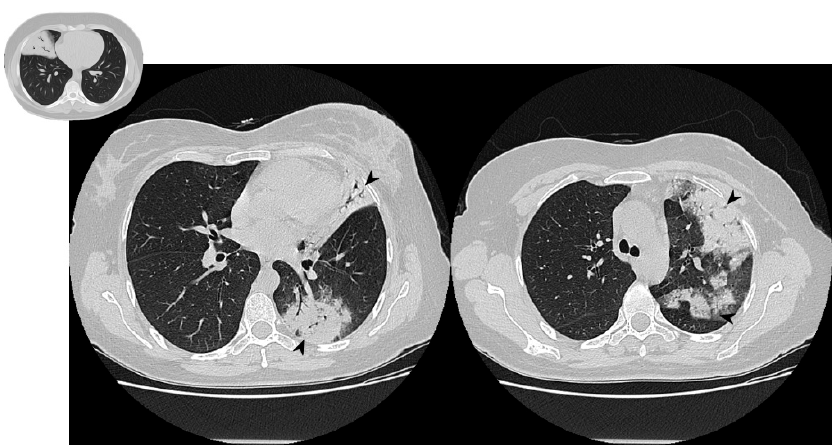
Figure 2. Typical pattern: multifocal and asymmetrical parenchymal consolidations (arrowheads), with peripheral distribution. These lesions may reproduce an air bronchogram sign in the